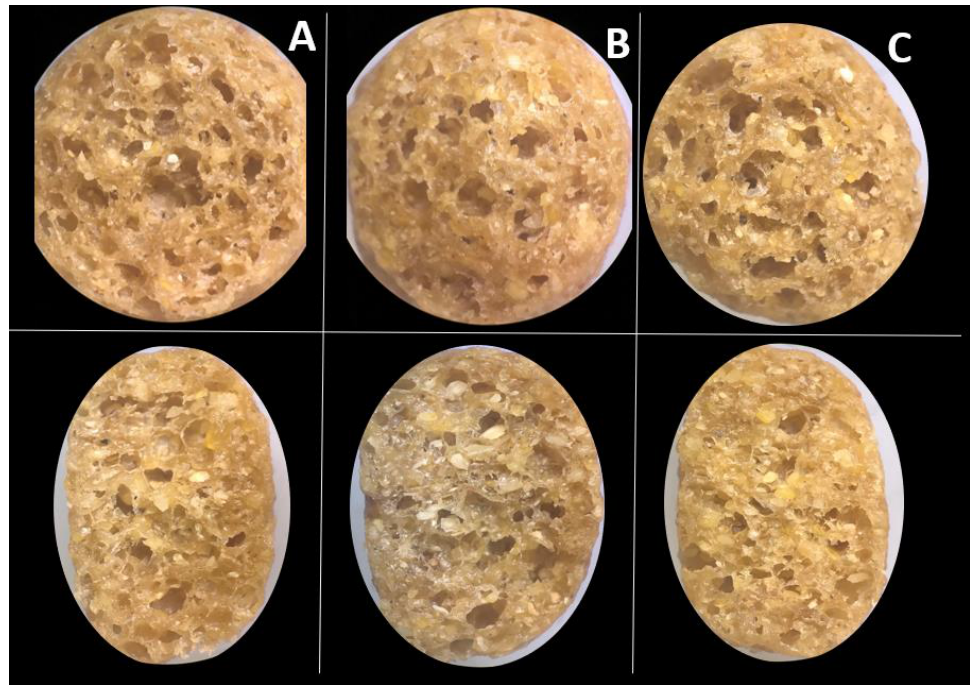
Figure 1 . Light microscopy images of sectional (top row) and longitudinal (bottom row) cut of ( A ) high shear kibble; ( B ) medium shear kibble; and ( C ) low shear kibble. During the production of diets through this production scale extruder (Wenger model X115) the extrudate temperature inside the die was not recorded due to a system failure. To estimate steam flash-off at the die for kibble expansion calculation, die temperature was one of the factors needed. Hence, it was estimated by Equations (2) and (3):